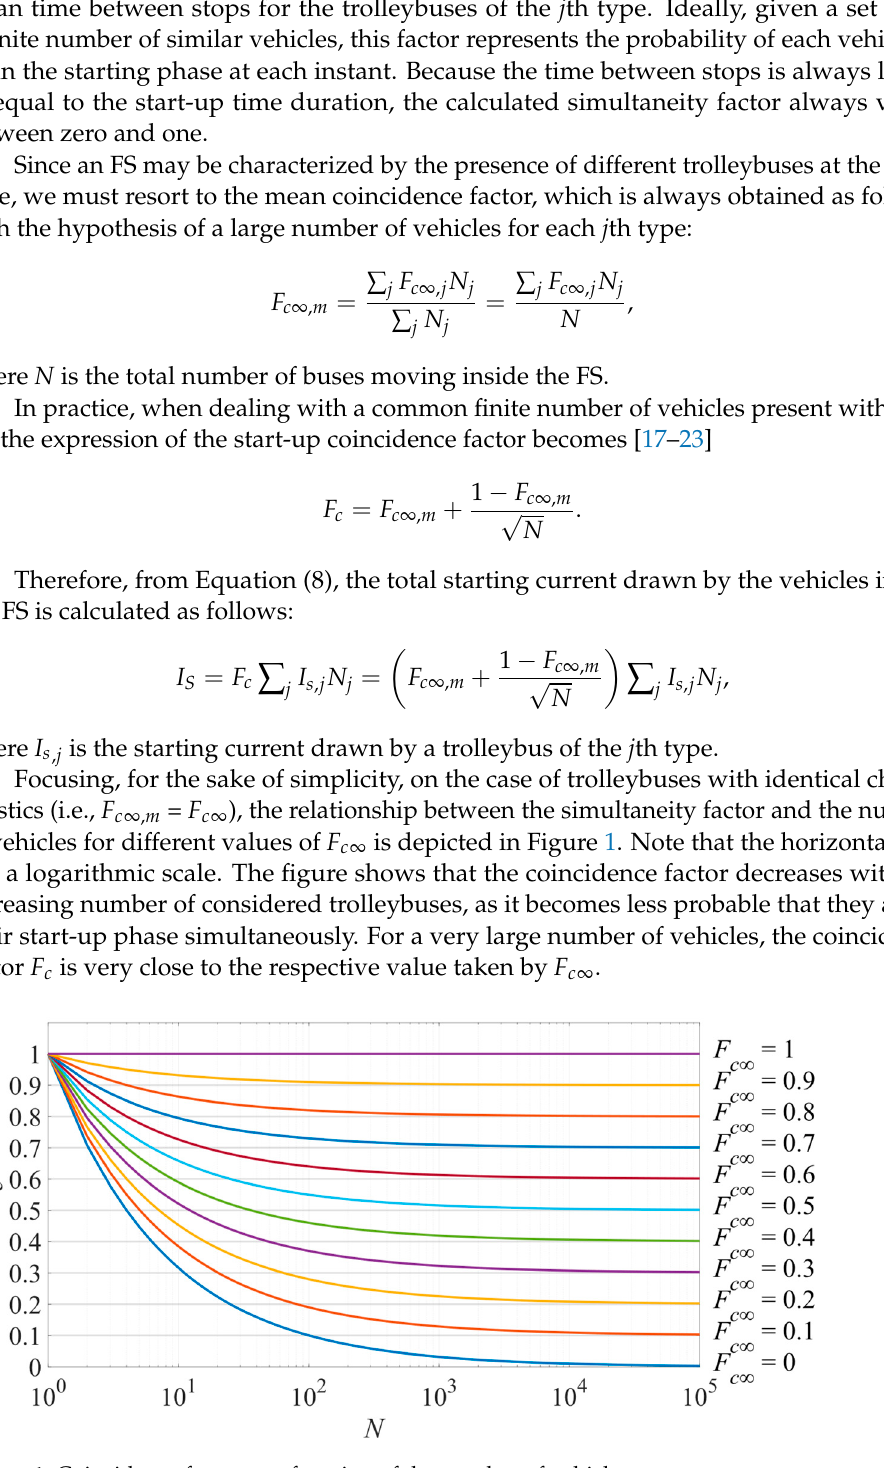
Figure 1. Coincidence factor as a function of the number of vehicles. It is assumed that the line section AB is fed at the A